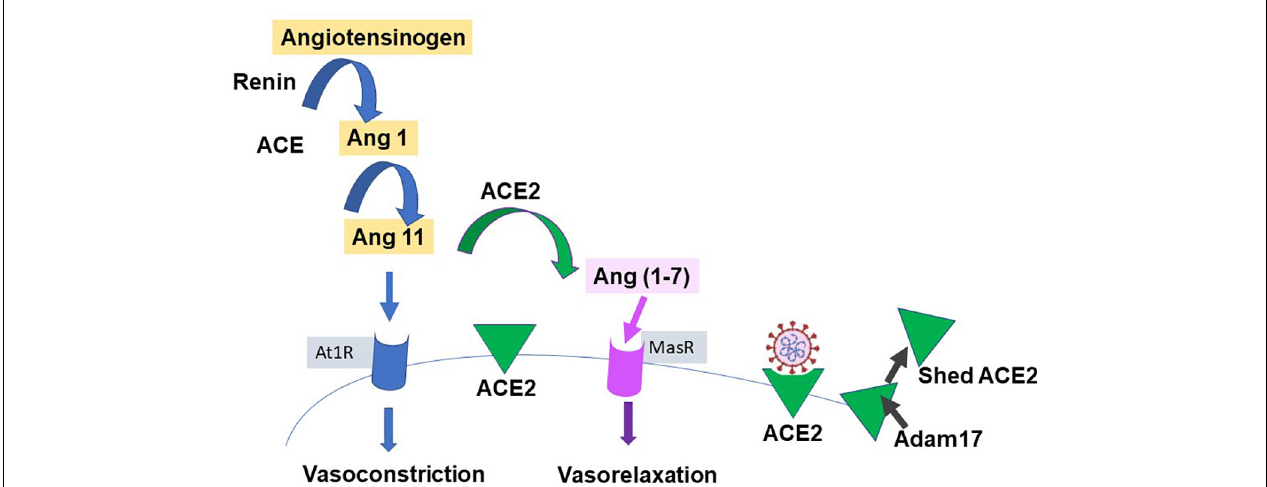
FIGURE 3 | Simplified renin-angiotensin system. Scheme shows the role of ACE2 as both the catalysis for Ang(1-7) creation, with a vasodilatory effect on vascular smooth muscle, and as the receptor for SARS-CoV-2. Proteases such as those of the Adam group act to cause shedding of ACE2 into plasma.